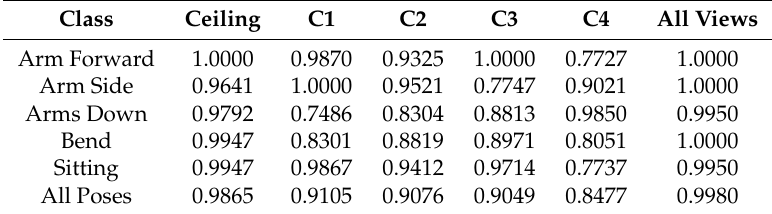
Table 5. Specificity results from the five TISs test where C = corner.